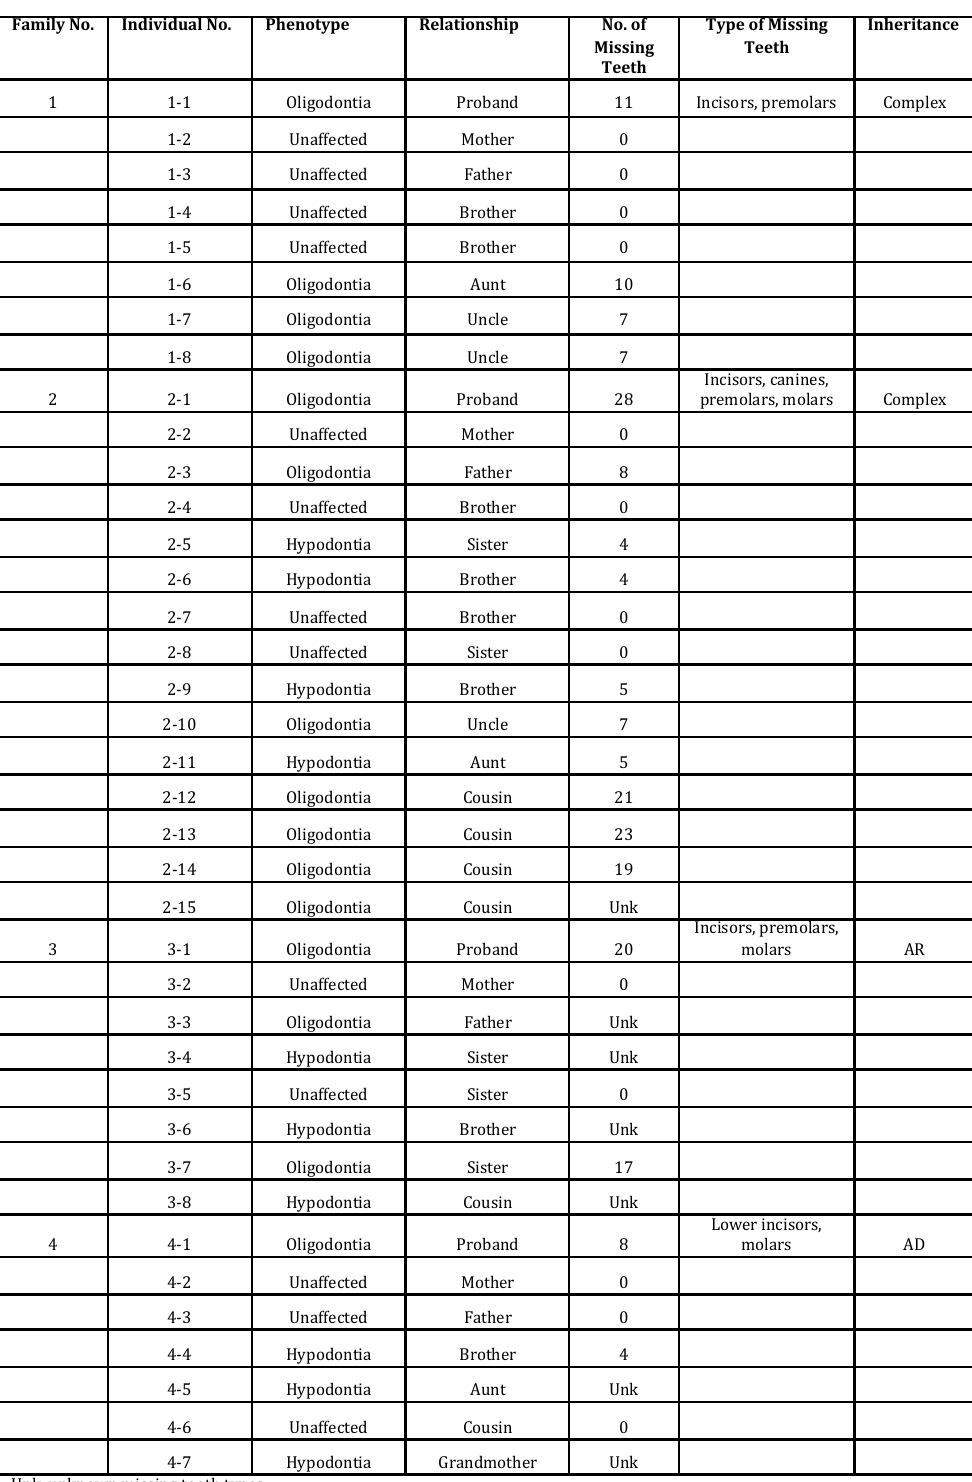
Table&1. !Details!of!study!families.! Family&No.&